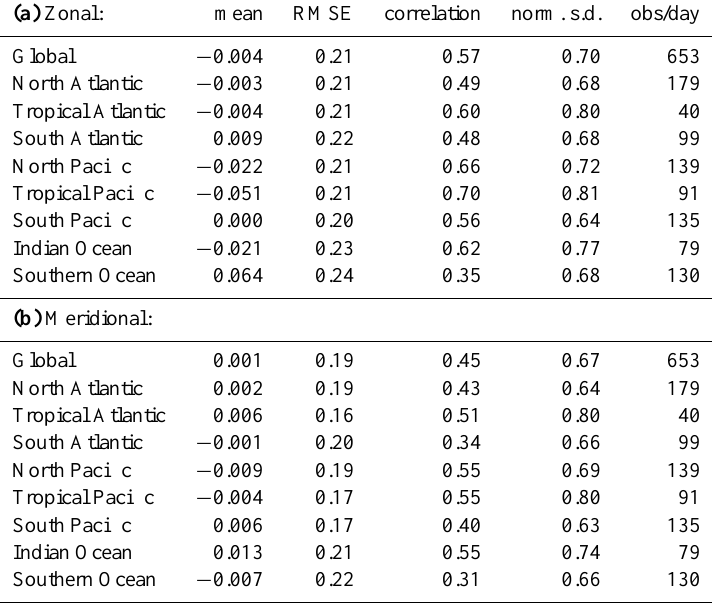
Table 2. Drifter-derived current validation of the FOAM V1 2007–2008 hindcast zonal velocities (a) and meridional velocities (b). Sum- mary statistics shown include the mean error (observed-modelled), root-mean-square error (RMSE), Pearson correlation coefficients and normalised standard deviations (the ratio of standard deviation for the modelled and observed currents). Also shown are the average numbers of drifter-derived observations per day. Results are shown for the whole global ocean as well as various other regions. (a) Zonal: mean RMSE correlation norm. s.d. obs/day